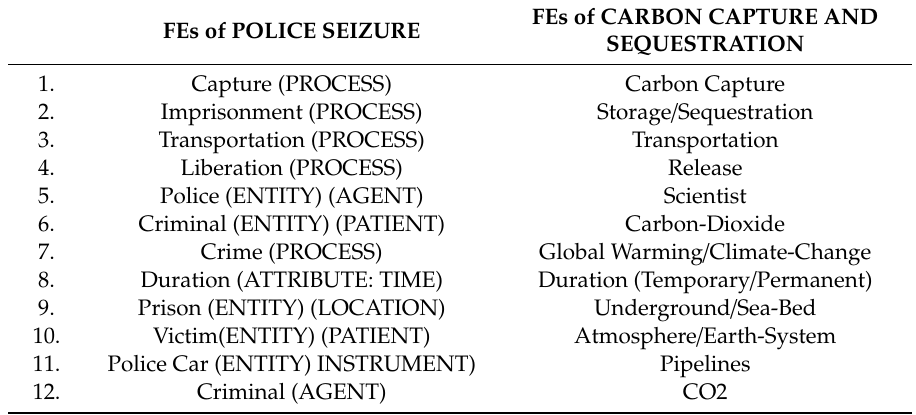
Mapping between the frames POLICE SEIZURE and CARBON CAPTURE AND